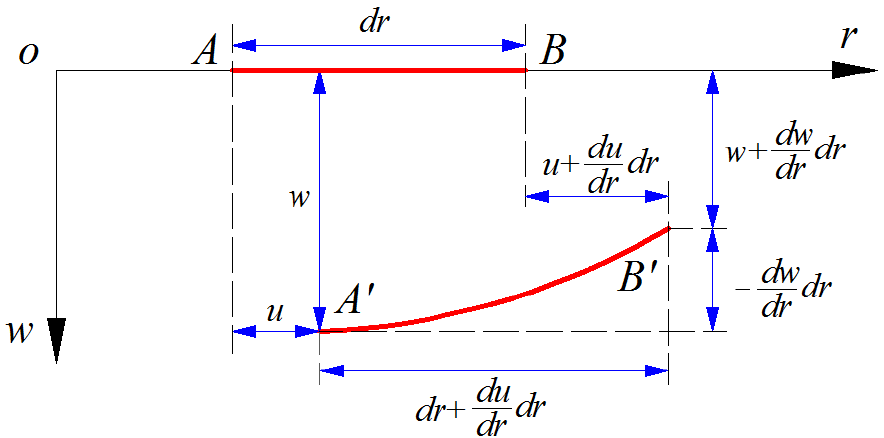
Figure 3. Sketch of the deformation of a line micro element.